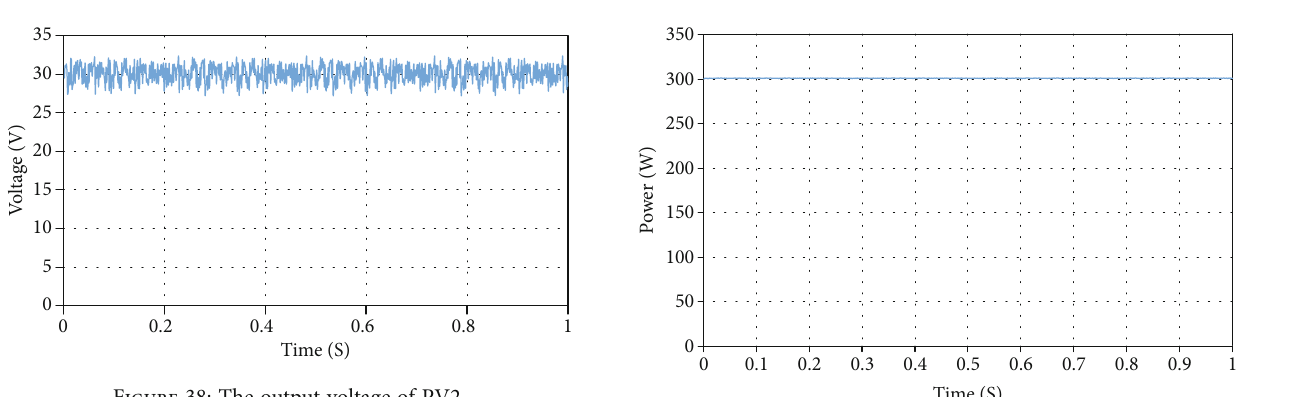
Figure 37: The output power of PV1.